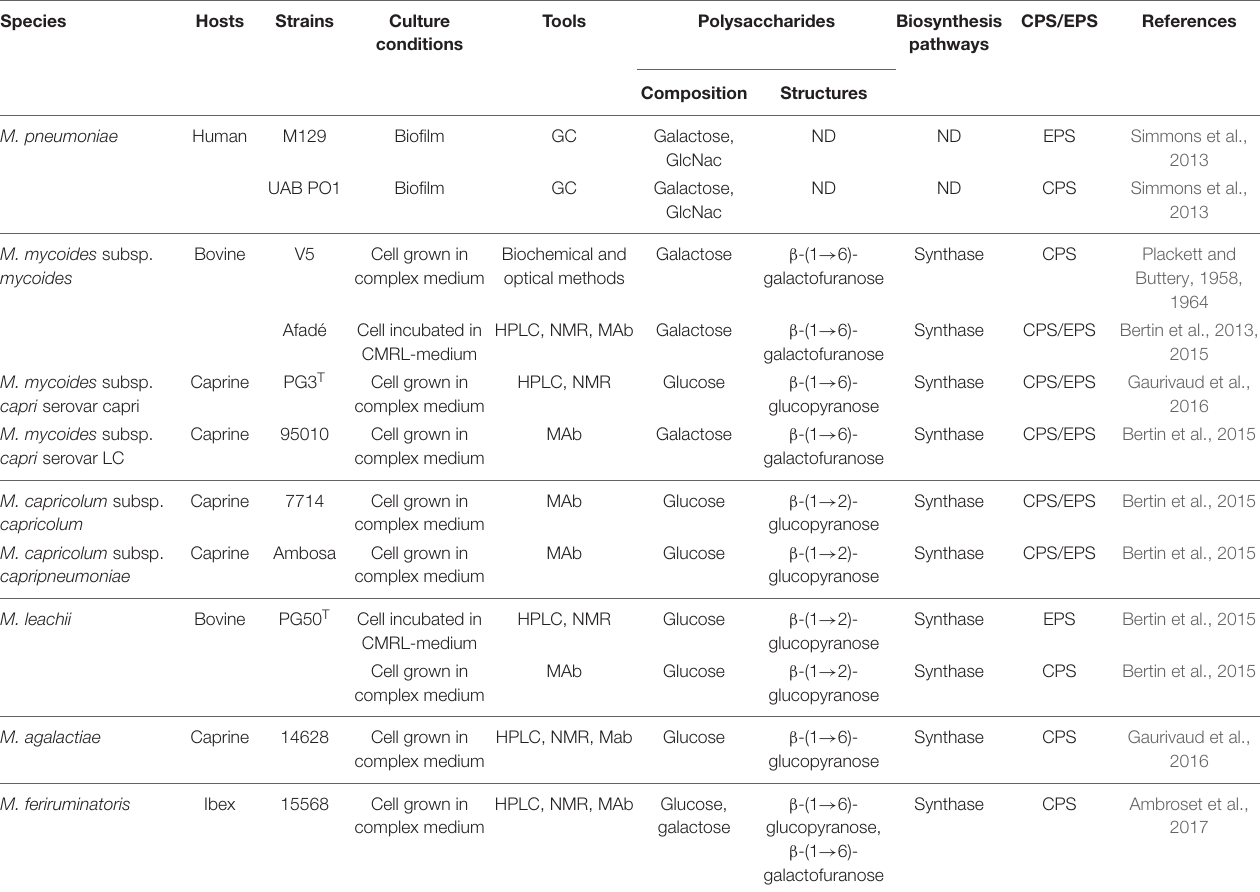
TABLE 2 | List of Mycoplasma (sub)species producing exopolysaccharides.